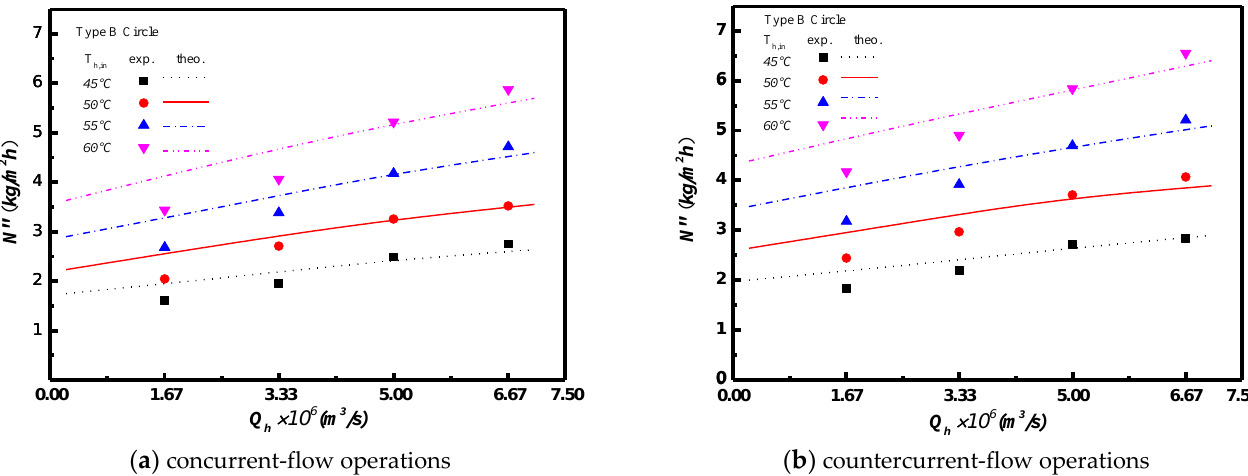
Figure 12. Effects of saline water flow rate and flow pattern on permeate flux for Type B Circle turbulence promoter.